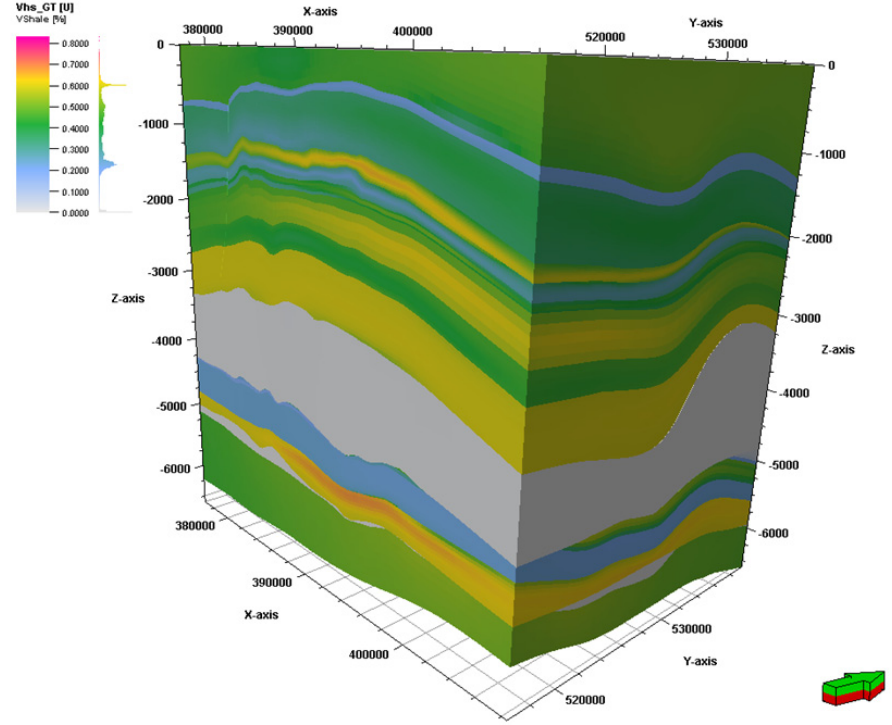
Figure 11. Spatial illustration of modeling results: model of shale volume (VSH) in variant 2.